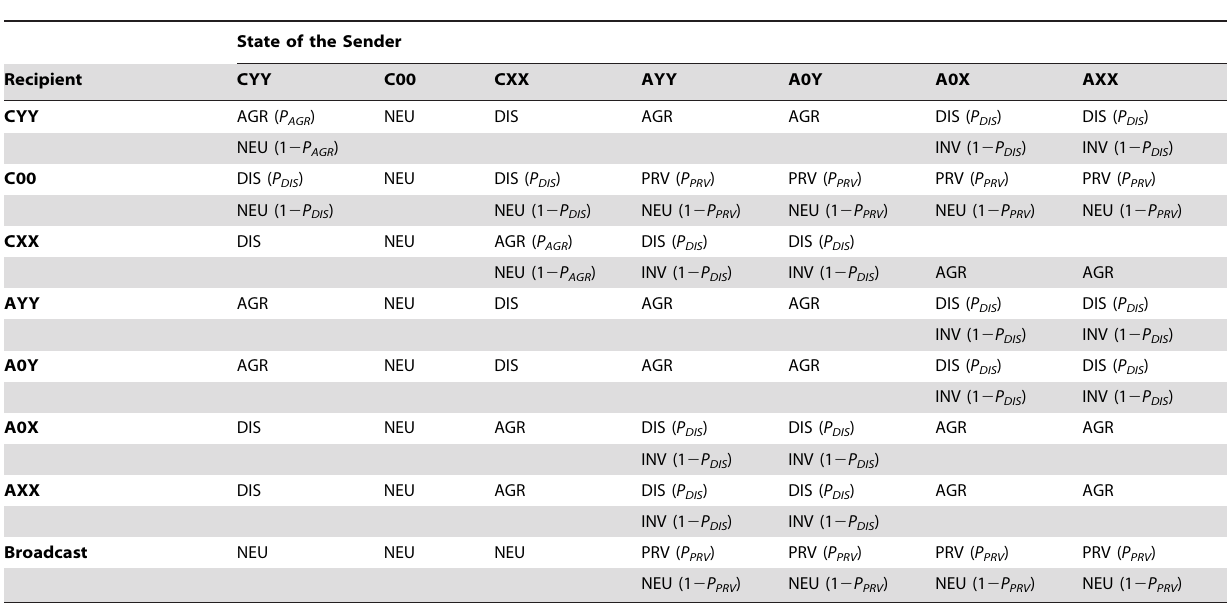
Table 2. Table of message types resulting from a combination of Sender state and Recipient state, including messages not addressed to a specific user (broadcast